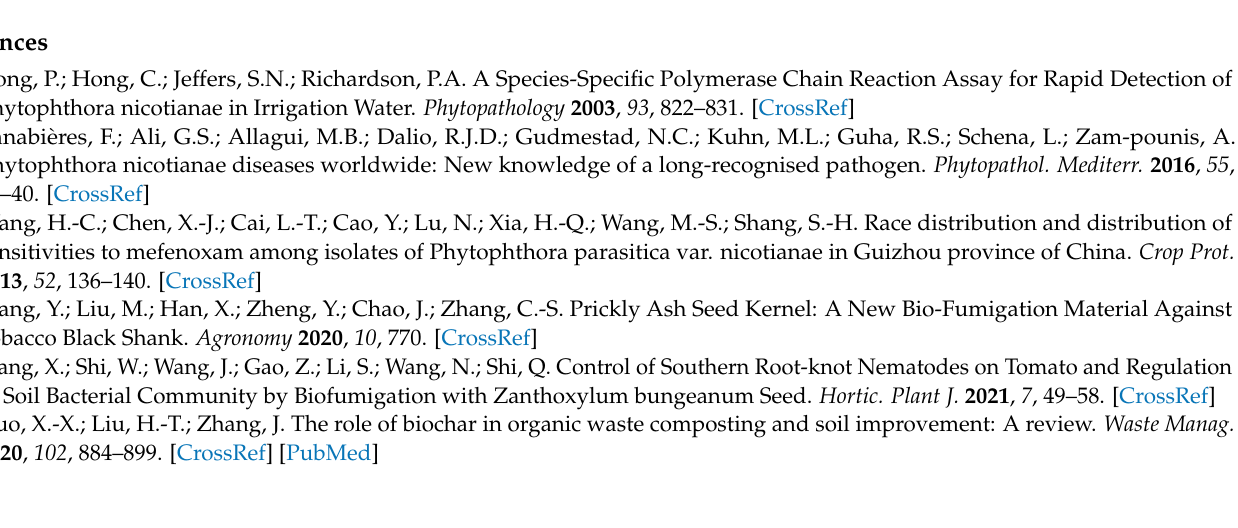
formulas, Table S1: ADONIS analysis using Bray–Curtis distance between PBB treatment and the control, Table S2: Partial Mantel test for whole OTUs of soil microbe versus environmental